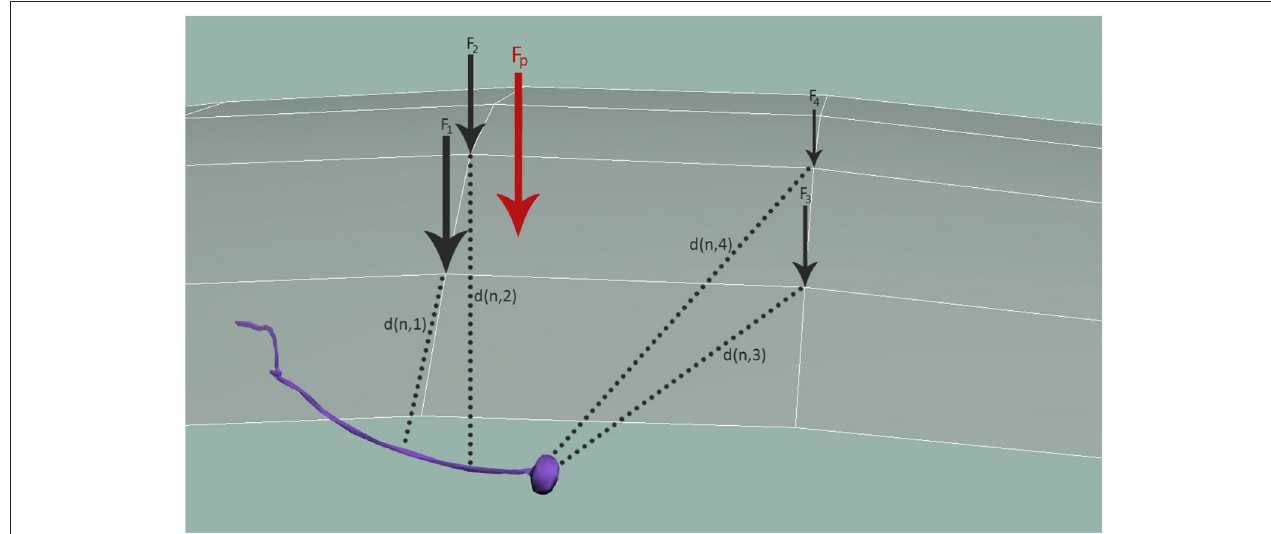
FIGURE 5 | Distribution of mechanosensation forces, F p , among neurons. F p is distributed to obtain all forces in the simulation nodes of the cuticle, F c . These forces are finally applied to neurons, modulated again with the distance between the neuron and each node, d ( n , i